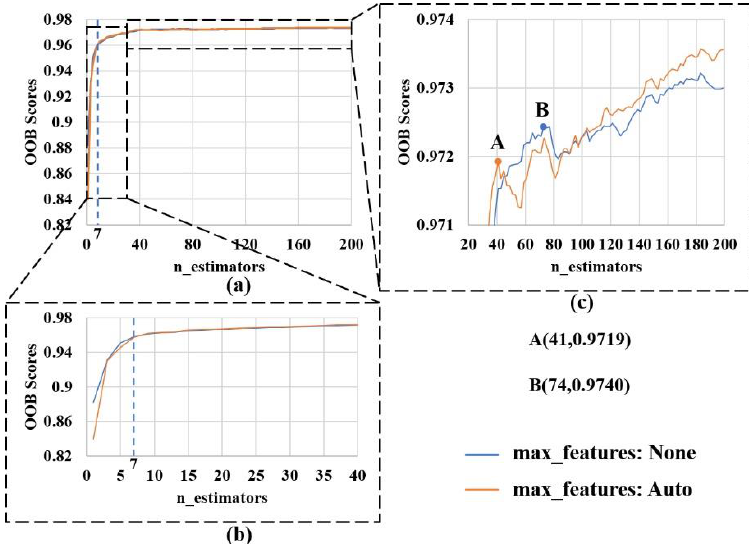
Figure 8. The changes of model Out Of Bag (OOB) scores ( y -axis) when tuning n_estimators ( x -axis) and max_features (blue line and orange line): ( a ) the changes with n_estimators ranging from 1 to 200; ( b ) the partial enlarged detail with n_estimators ranging from 1 to 40; ( c ) the partial enlarged detail with n_estimators ranging from 30 to 200.